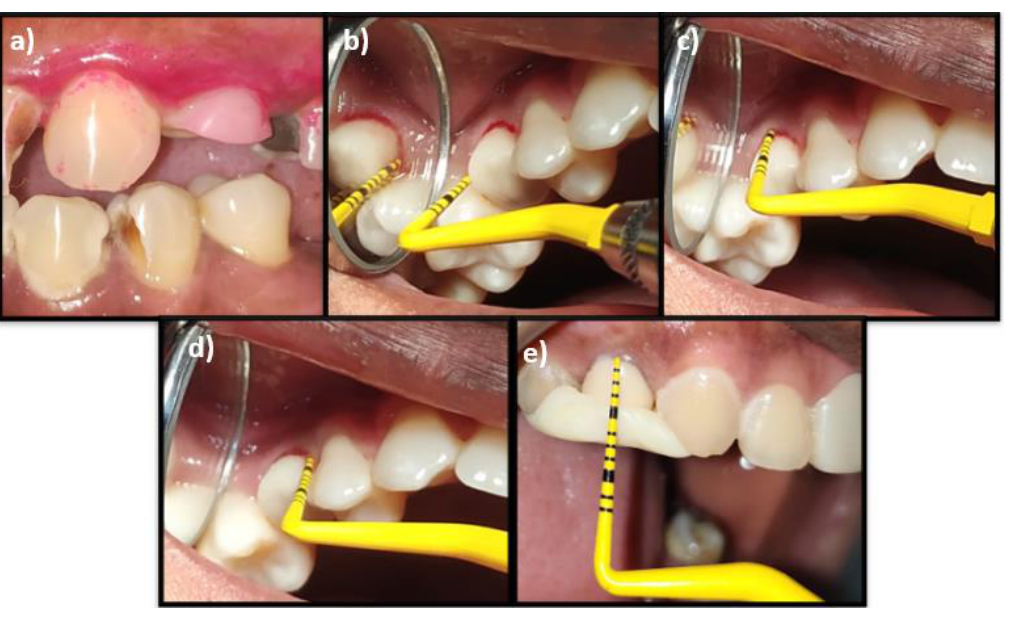
Figure 3. ( a ) Evaluation of site-specific plaque score using a disclosing agent; ( b ) Evaluation of the site-specific bleeding score; ( c ) Measurement of peri-implant sulcus depth; ( d ) Measurement of peri- implant abutment attachment level; ( e ) Measurement of the position of the relative gingival margin.